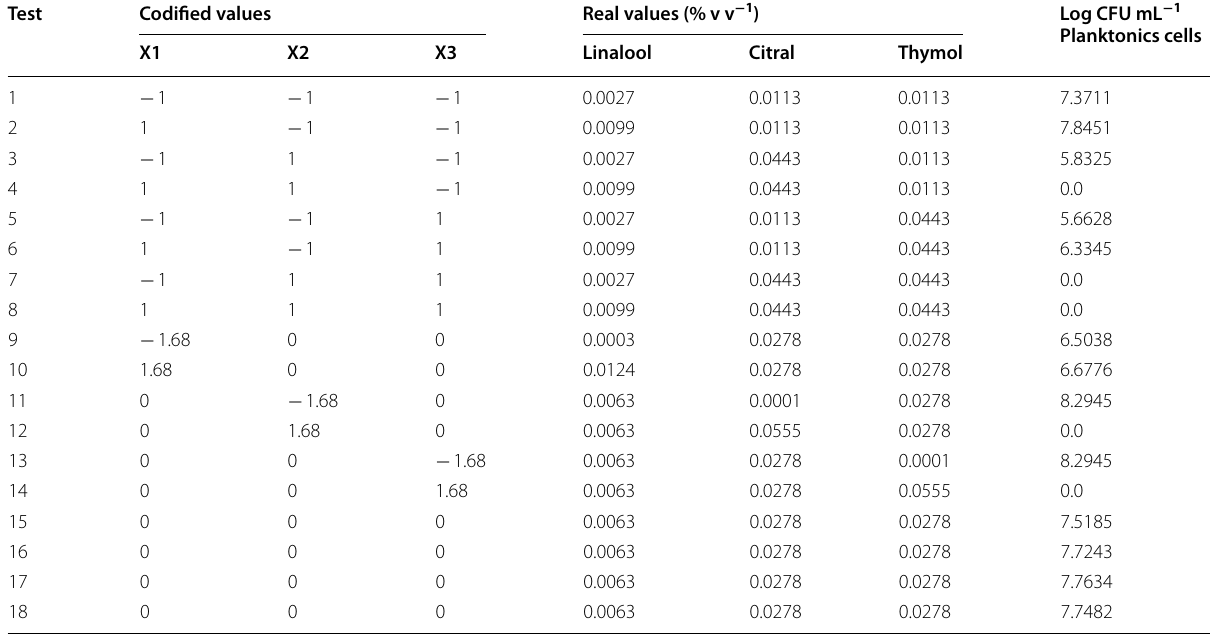
X1, X2, X3—coded and real values of linalool, citral and thymol concentrations